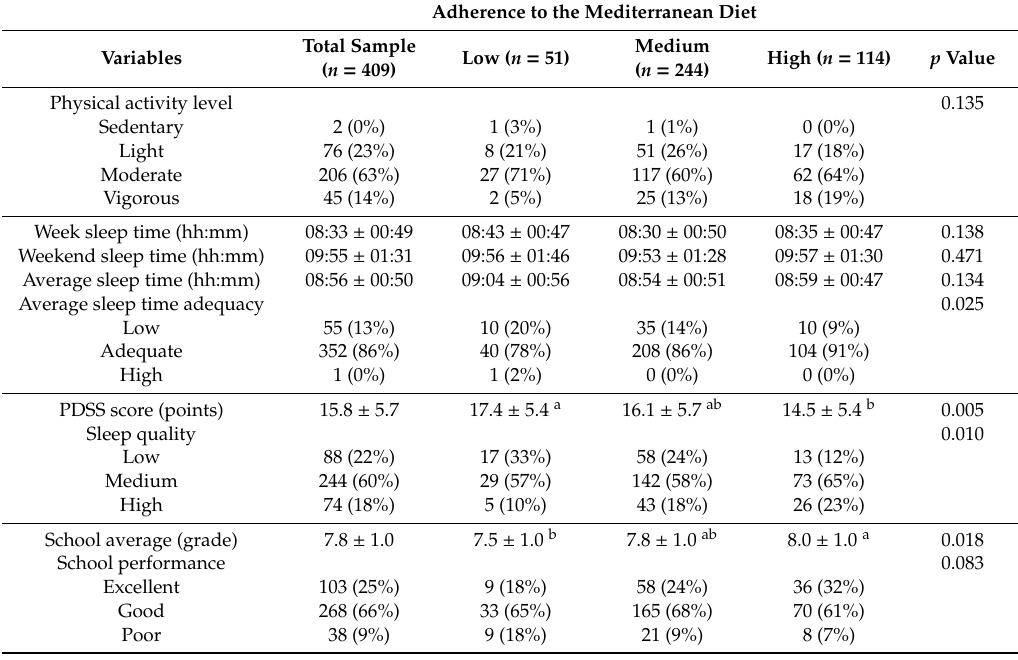
Table 3. Relations between adherence to the MD and PAL, sleep habits, and school